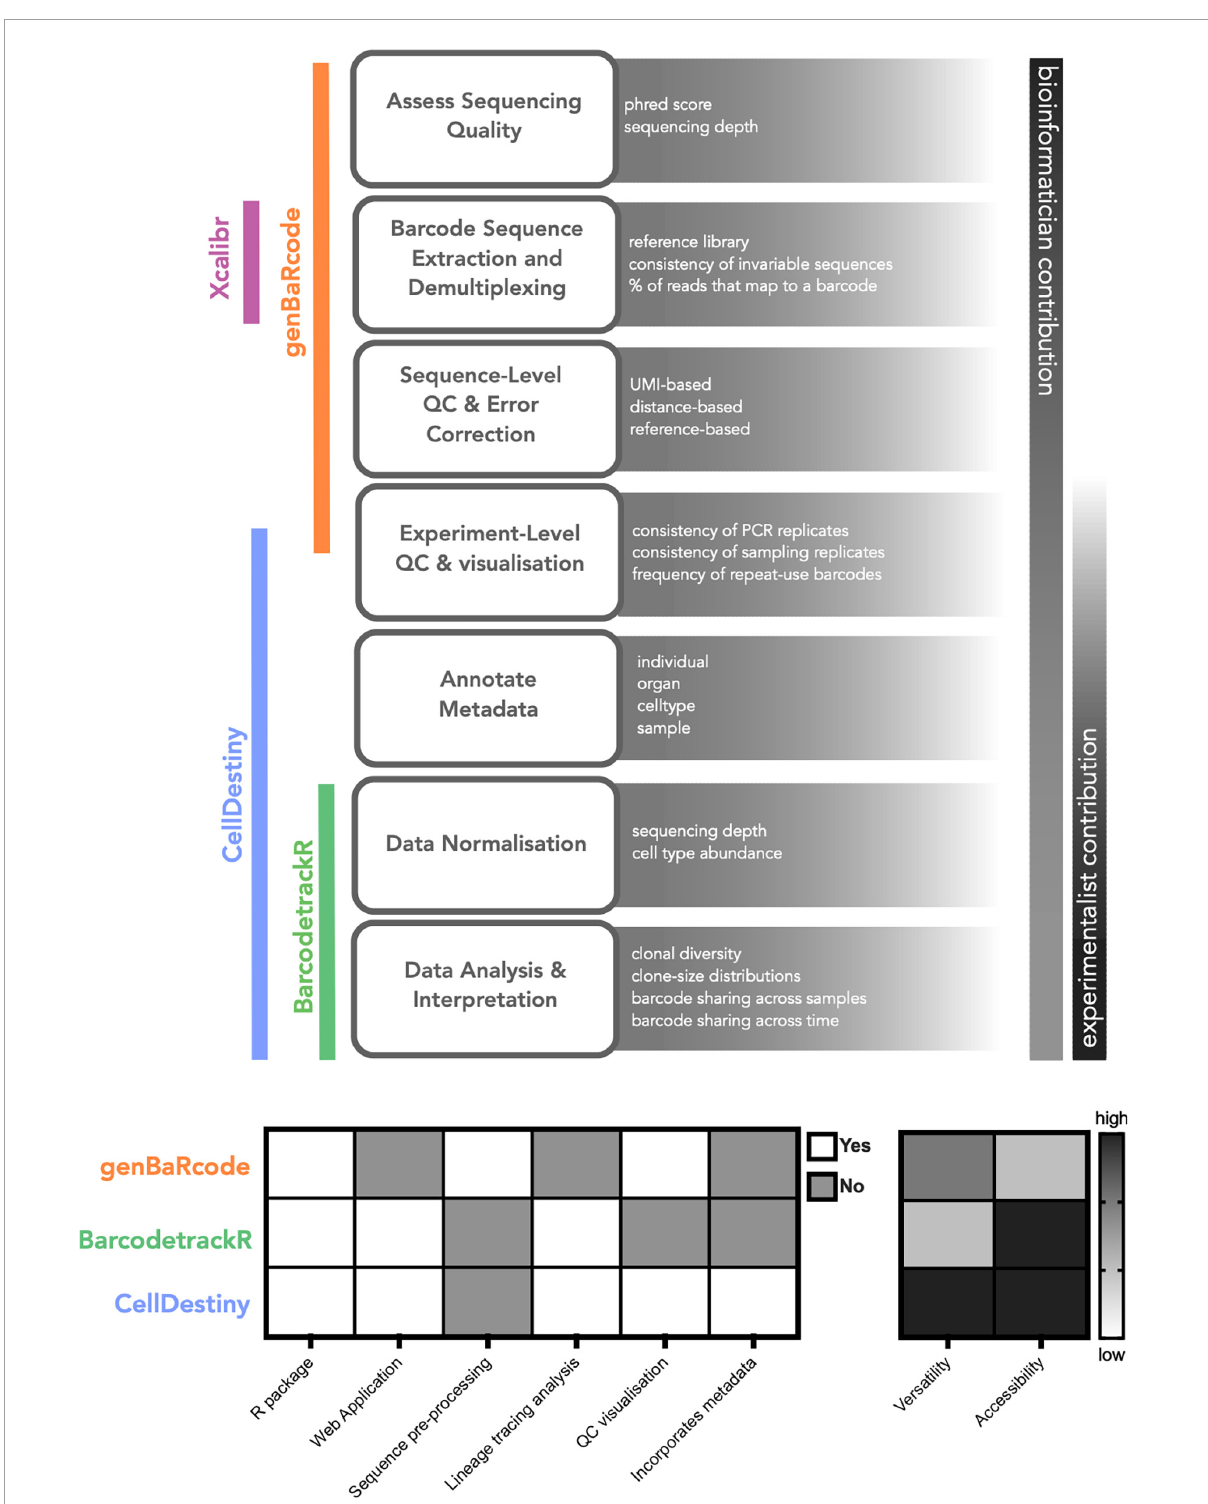
FIGURE1 Computational tools for lineage tracing data analysis. A generalized scheme for lineage tracing data analysis highlighting the relative contribution of experimentalists and analysts as well as the associated analysis toolkits for each step. We also provide a qualitative comparison of the different toolkits to illustrate their key functionality. When comparing the utilty of different toolkits the term versatility refers to whether the tool can incorporate metadata into the analysis framework, enabling comparisons across and within technical and biological